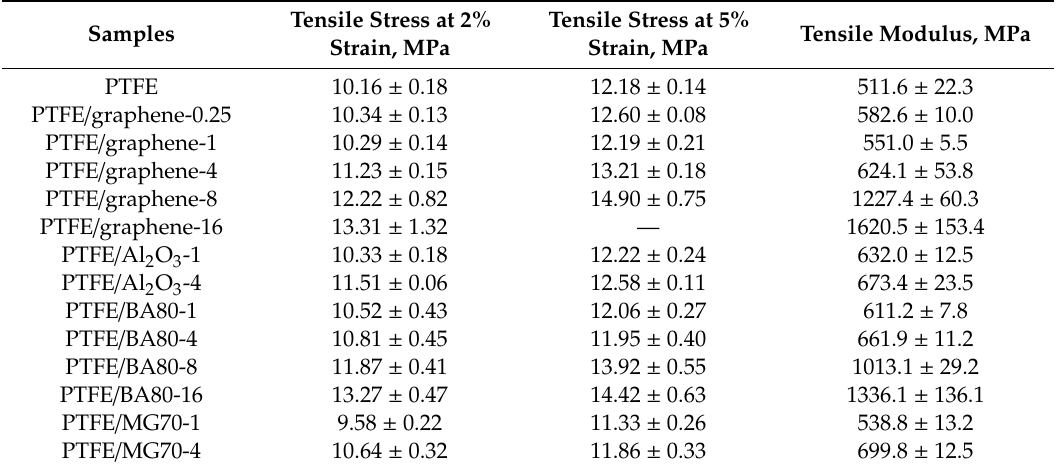
Table 7. Average tensile stress at 2% and 5% strain and average tensile modulus of the sintered materials.